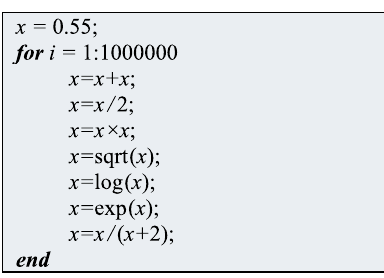
Figure 15. Procedure of T 0 assessment.